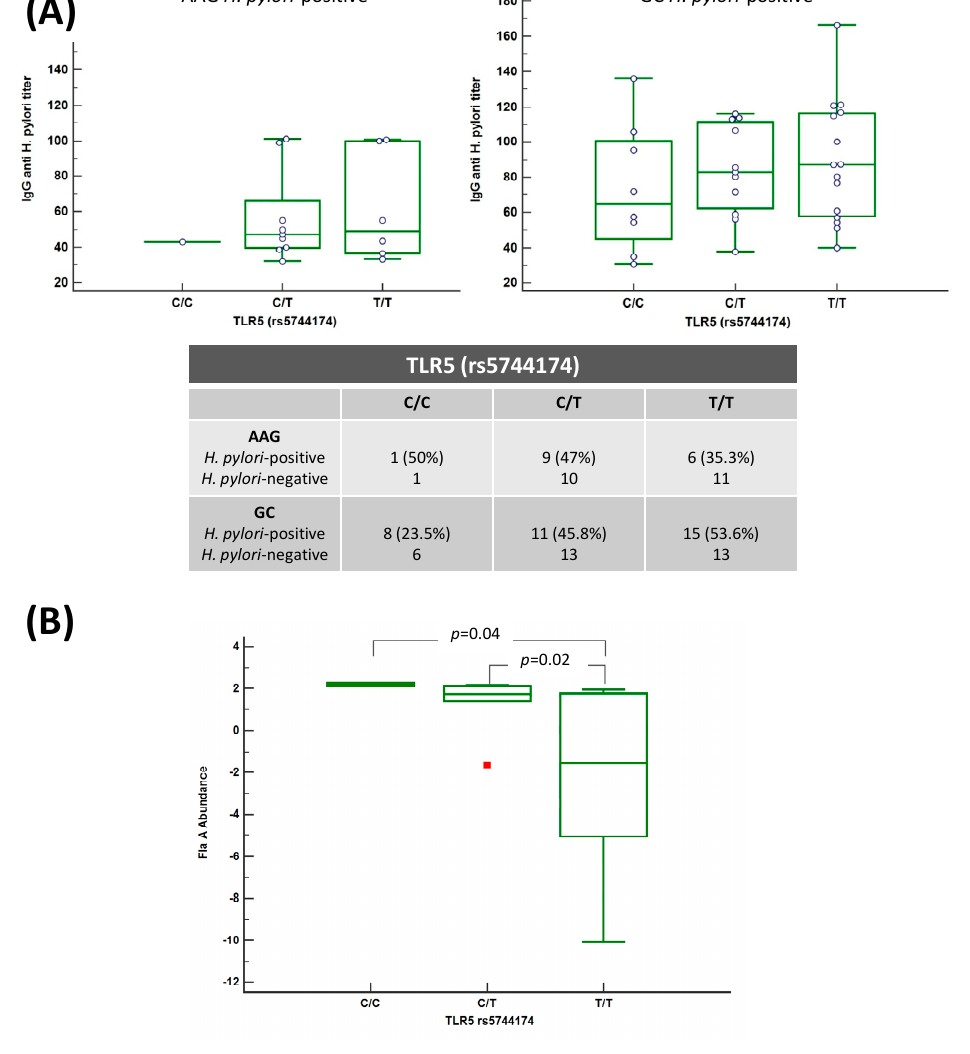
Figure 5. H. pylori IgG antibody titer and flaA abundance were associated with TLR5 genotype. ( A ) Figure illustrates the mean of H. pylori IgG titer stratified based on the presence of TLR5 rs5744174 genotype. Samples tested n = 100, 60 were GC and 40 AAG. IgG anti- H. pylori titer showed a slight tendency to increase in the genotype T / T, and in particular in the GC group of patients. ( B ) The mean of flagellin A abundance in H. pylori strain isolates is lower in the isolates of patients carrying the TLR5 rs5744174 genotype T /